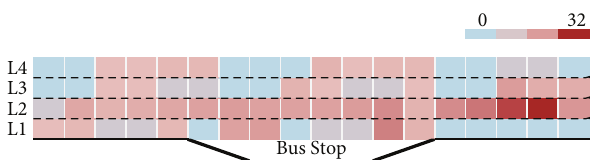
Figure 7: Lane-changing location heat